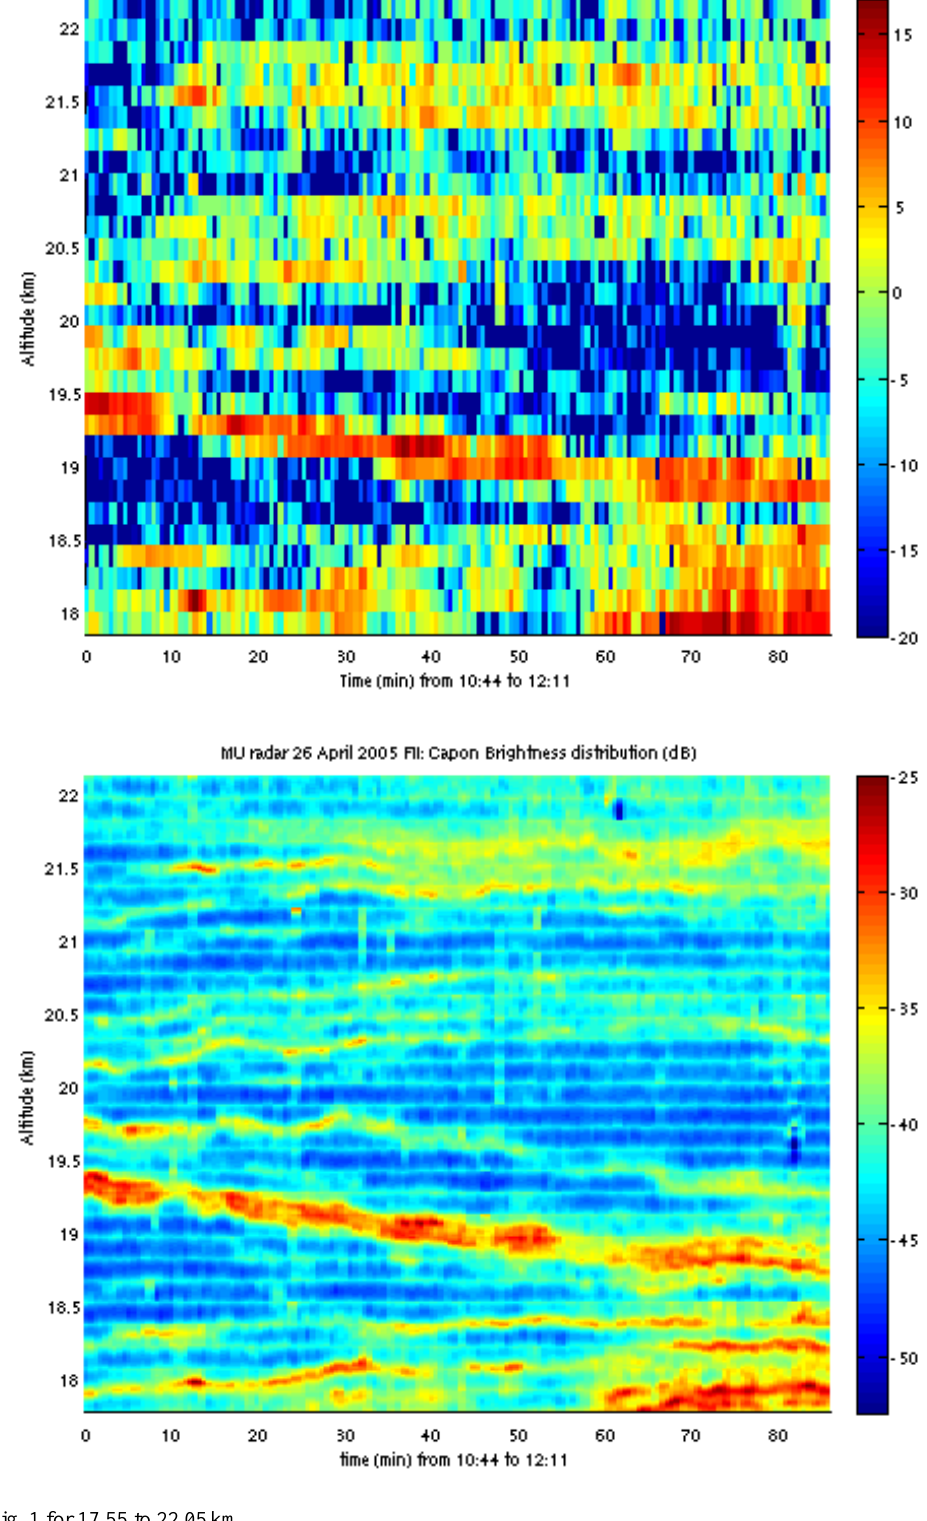
Fig. 4. Same as Fig. 1 for 17.55 to